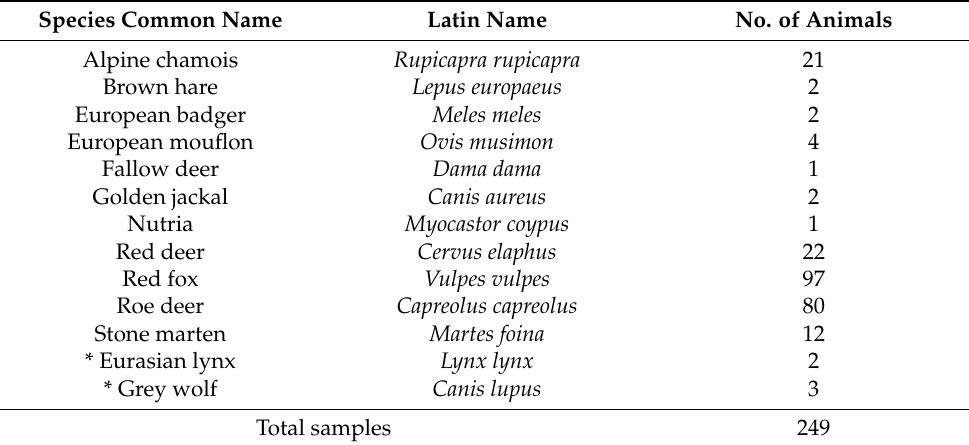
Table 1. Samples from 249 free-ranging wild animals, harvested or found dead